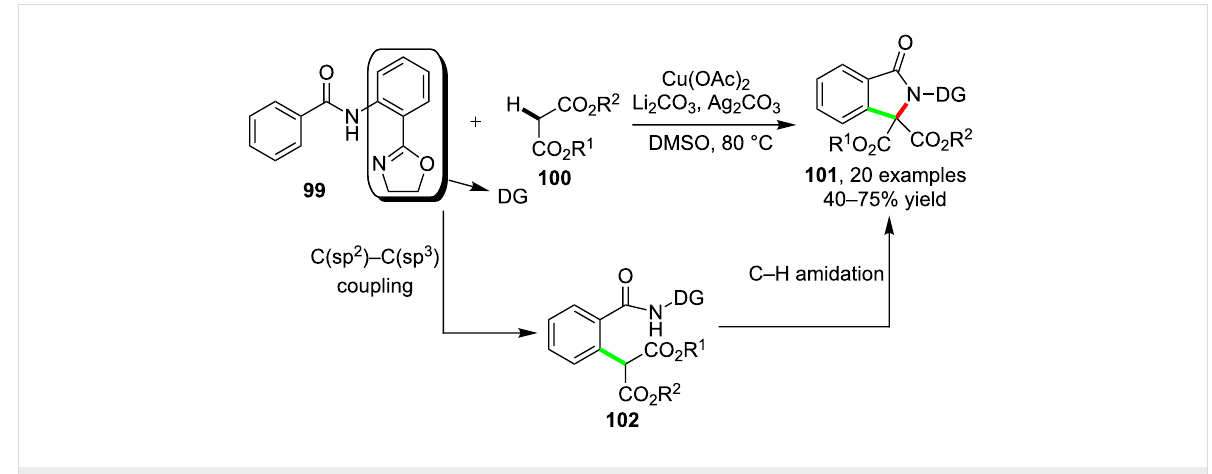
Scheme 26: Copper-catalyzed cascade reactions for the synthesis of indolinones.